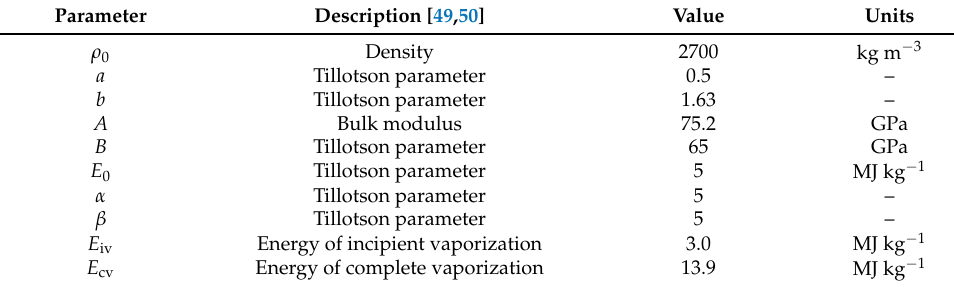
Table 1. Tillotson equation of state parameters for